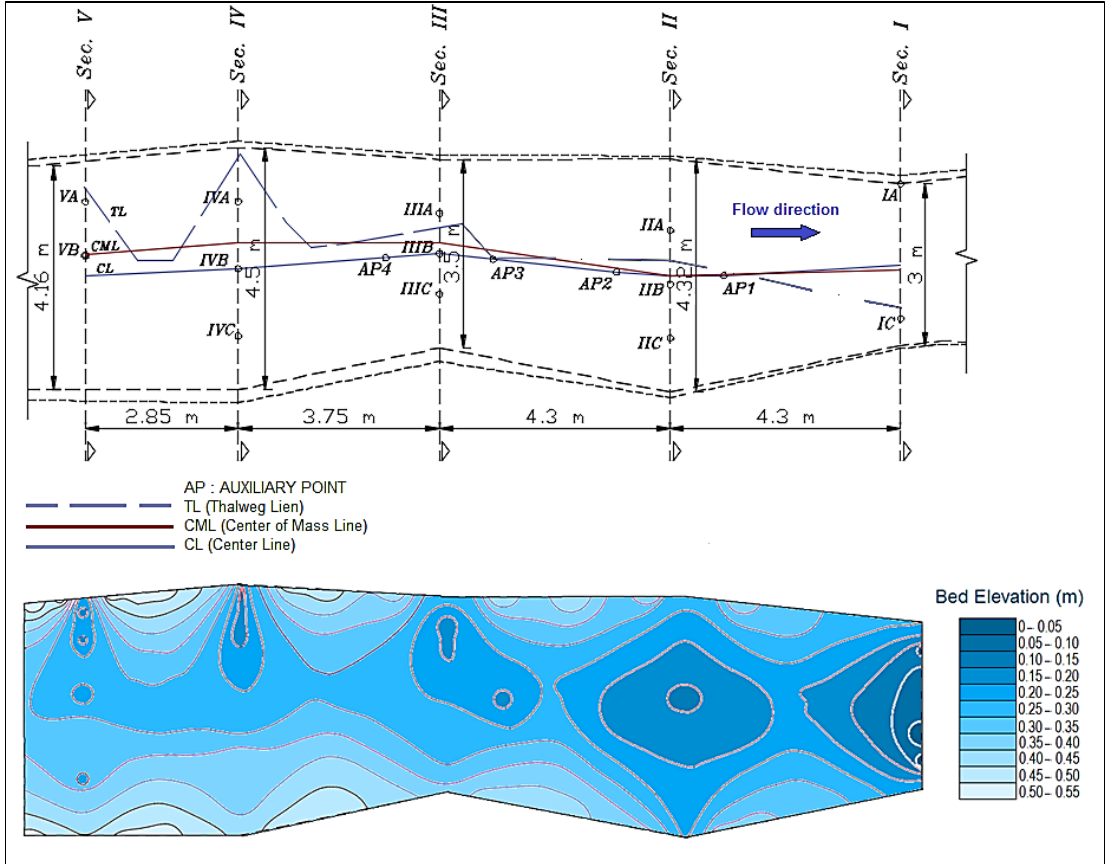
Figure 5. Topography of the bed, river plan, and the location of the sections in the selected reach (The lowest point has been set as the baseline of local elevation code)—Marbor River.